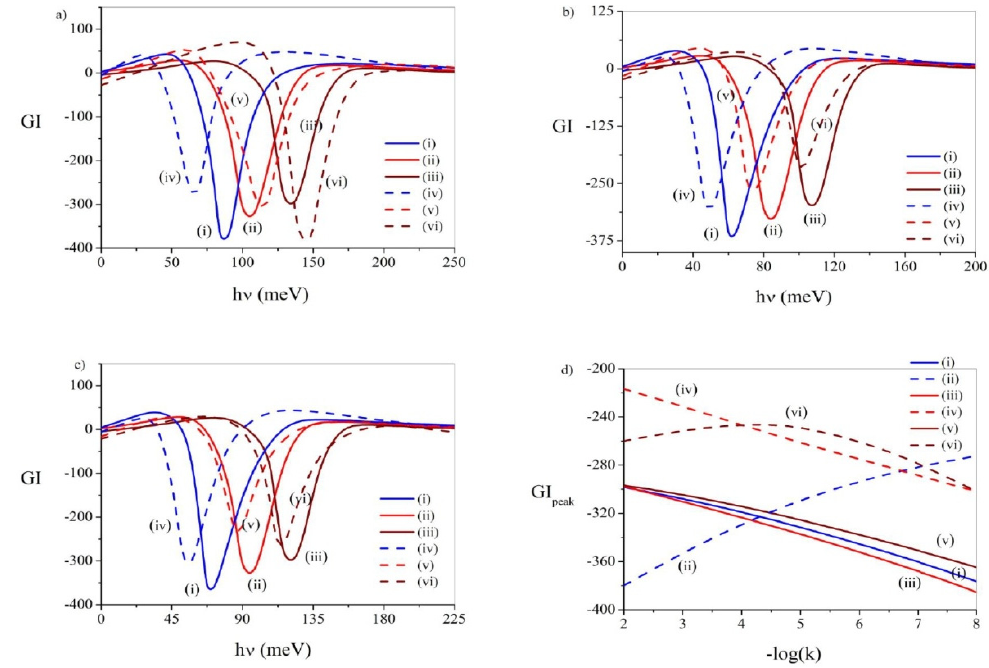
Figure 16. GI vs. h υ diagrams ( a ) devoid of noise, ( b ) under ADWN and ( c ) under MLWN. In these diagrams the anharmonicity has (i) odd parity and k = 10 − 8 , (ii) odd parity and k = 10 − 5 , (iii) odd parity and k = 10 − 2 , (iv) even parity and k = 10 − 8 , (v) even parity and k = 10 − 5 , (vi) even parity and k = 10 − 2 . ( d ) Depiction of GI peak values vs. − log(k): (i) devoid of noise and OPA, (ii) devoid of noise and EPA, (iii) with ADWN and OPA, (iv) with ADWN and EPA, (v) with MLWN and OPA and (vi) with MLWN and EPA.